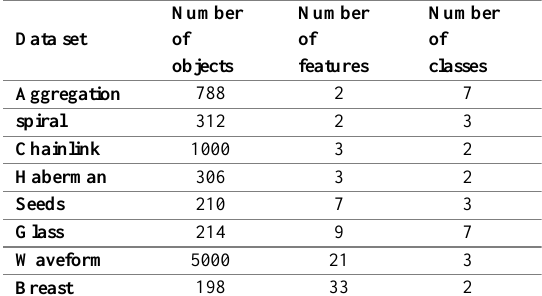
Table 1. Summary of the datasets.